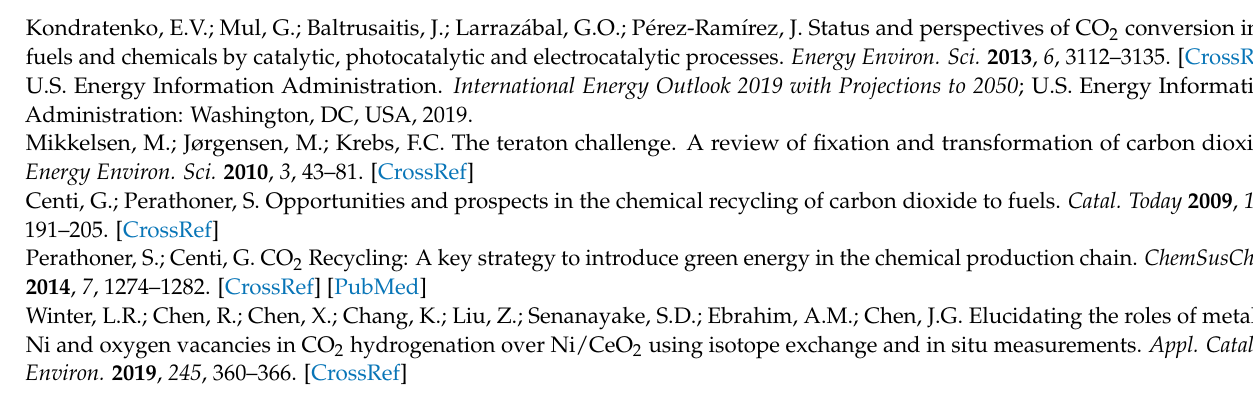
fitting section. Figure S5. Ni 2 p 3/2 NAP-XPS spectra recorded at KE = 550 eV (A) and KE = 190 eV (B) corresponding to 5Ni-CeO 2 NCs under 1 mbar H 2 at different temperatures: (a) 250 ◦ C, (b) 300 ◦ C, and (c) 350 ◦ C. Figure S6. Ni 2p 3/2 obtained at KE = 190 eV for 5Ni-CeO 2 NCs under 1 mbar H 2 at 500 ◦ C. Table S1. C 1 s and O 1 s peak fitting